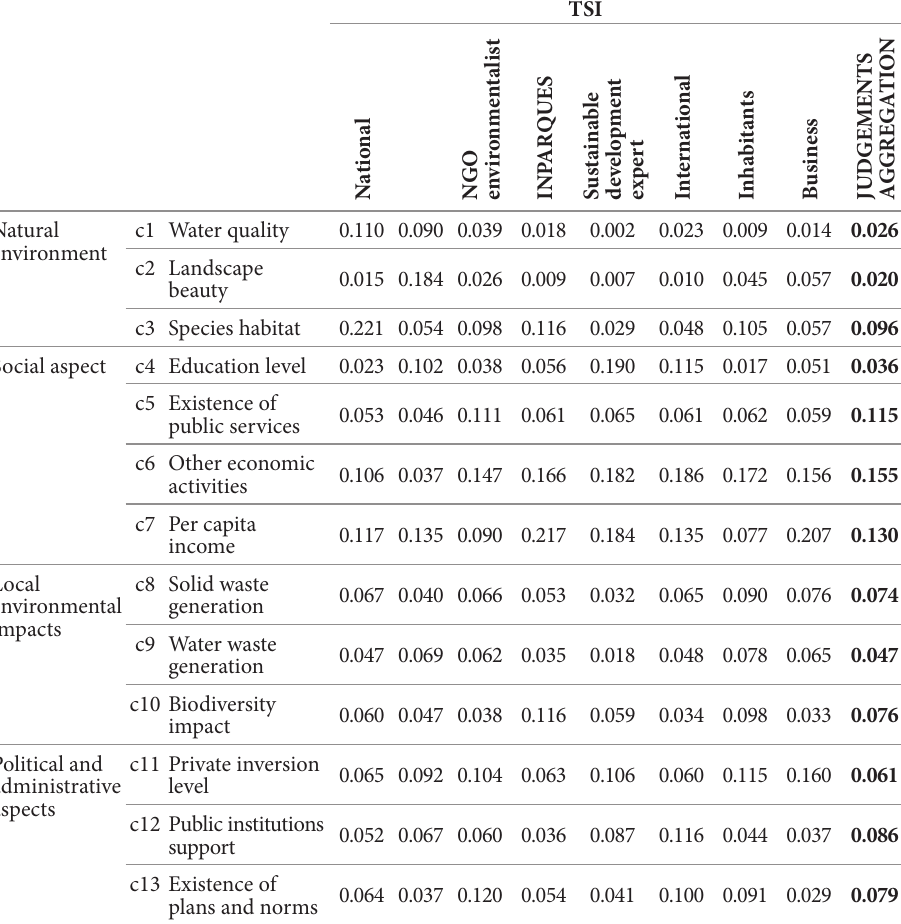
Table 6. Individual and global prioritization for the case